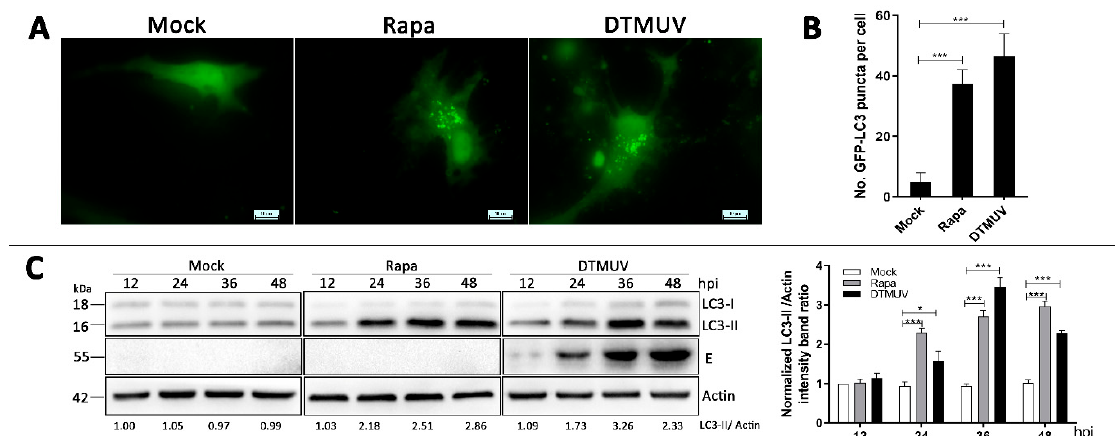
Figure 2. Measurement of autophagic markers in DEF cells infected with DTMUV. ( A ) DEF cells were transfected with GFP-LC3 plasmids for 24 h prior to experiment. Then, cells were mock-treated as a negative control, Rapa treated (1 µ M) as a positive control, or infected with DTMUV at an MOI of 1 for 36 h. Cells were fixed and imaged for GFP fluorescence. The images shown were representative of three independent experiments. ( B ) Quantification of the numbers of GFP-LC3 puncta per cell in each group were quantified, and the average number of the puncta in each cell was obtained from 50 cells undergoing each treatment. ( C ) DEF cells were mock-infected, Rapa treated, or infected with DTMUV at an MOI of 1 for 12, 24, 36, and 48 h. Samples were harvested for Western blot analysis and immunoblotted for LC3, DTMUV-E, and β -actin. The ratio of LC3-II to β -actin was normalized to control conditions in mock-infected cells. Error bars: Mean ± SD of three independent experiments. Two-tailed Student’s t -test; * p < 0.05, *** p < 0.001 compared to control.